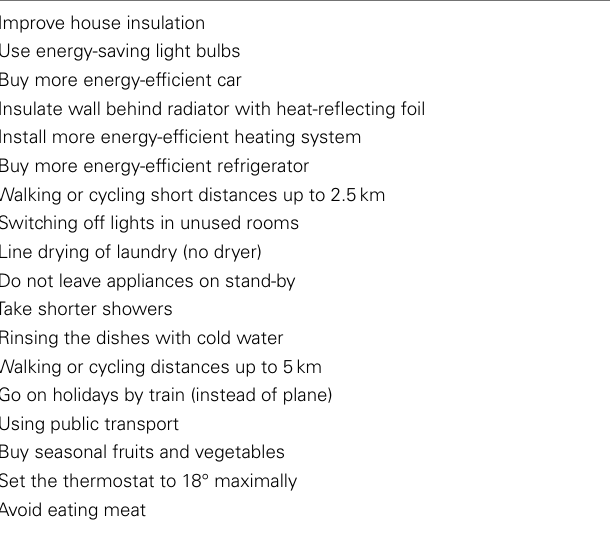
Table 1 | List of energy-saving behaviors covered in the questionnaire (adapted from Poortinga et al., 2003; Poortinga et al., 2004) .